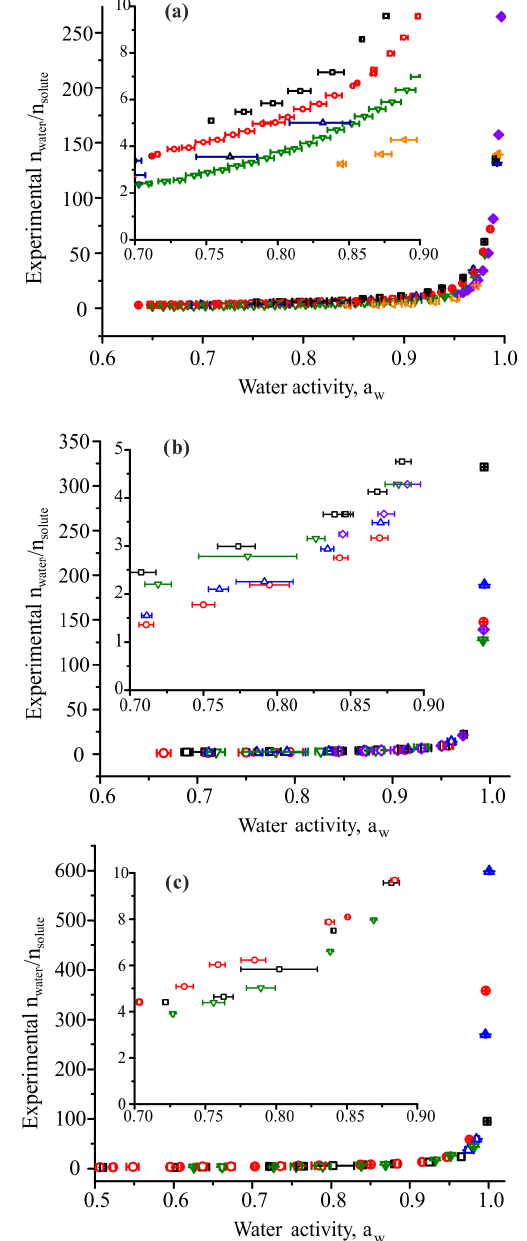
Figure 6. Moles of water per mole of solute for (a) straight-chain dicarboxylic acids for oxalic (black squares), malonic acid (red cir- cles), succinic acid (upward blue triangles), glutaric acid (down- ward green triangles), adipic acid (violet diamonds) and pimelic acid (leftward orange triangles); (b) diethylmalonic acid (black squares), 2,2-dimethyl glutaric acid (red circles), 3,3-dimethyl glu- taric acid (blue triangles), 3-methyl adipic acid (downward pink tri- angles) and pimelic acid (green diamonds); and (c) galactose (black squares), sorbitol (red circles), xylose (downward blue triangles) and erythritol (downward green triangles).